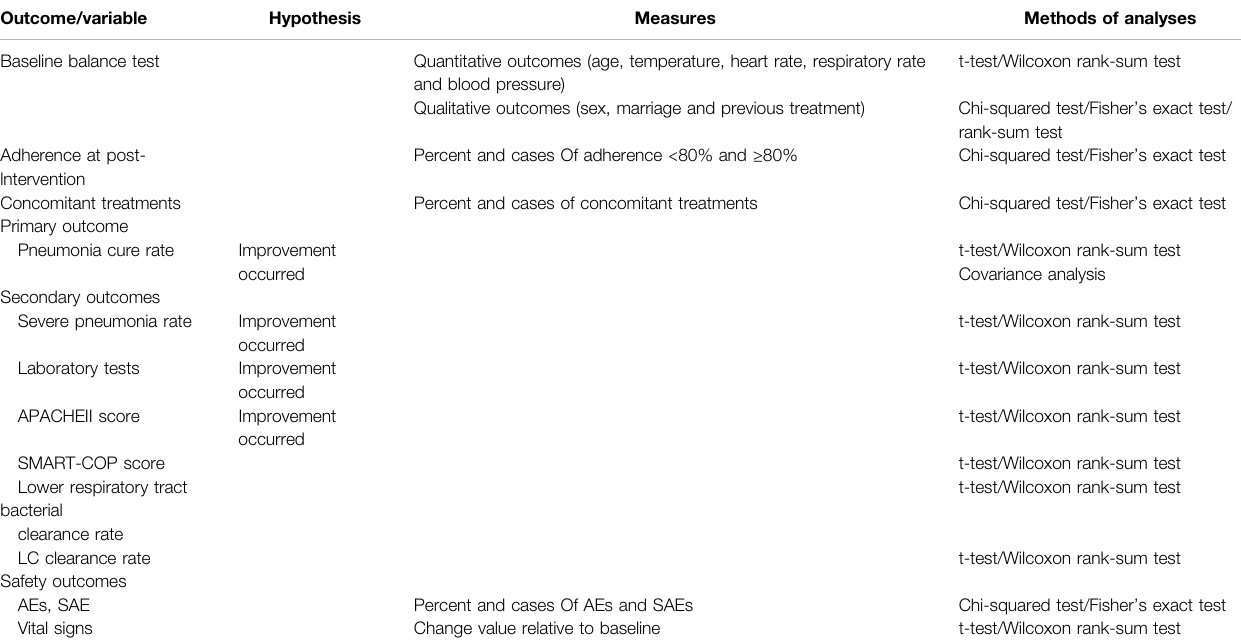
TABLE 3 | Outcomes and methods of